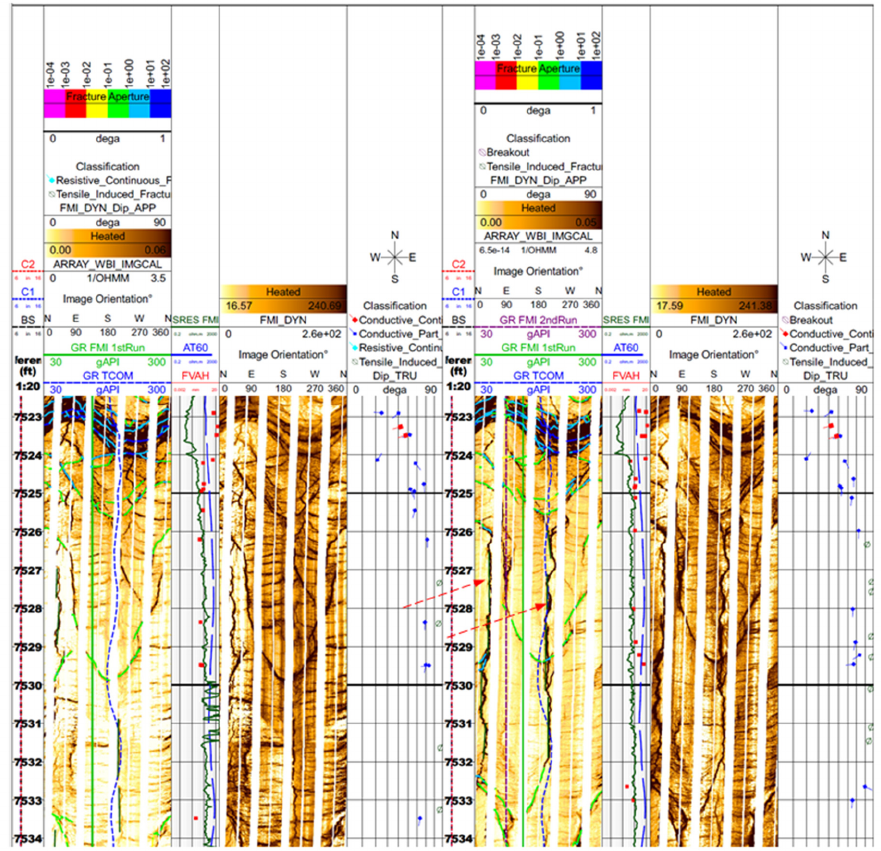
Figure 3. Comparison of Formation MicroScanner Image (FMI) logs before (left two tracks) and after (right two tracks) injection during 2017. Induced fractures are near-vertical and are shown by circles with azimuth trends to the right of the tracks. Blue tadpole symbols show the direction and dip of natural fractures. The arrows point to induced fractures that display the significant enhancement and growth after injection. Depths are in feet (to convert to meters, multiply by 0.3048). For each pair, the lighter leftmost panel is known as a static view, and the rightmost panel is a dynamic view. In “static normalization”, the resistivity range of the entire logged interval is partitioned into 256 color levels. “Dynamic normalization” can enhance features locally by rescaling the color intensity over a smaller interval, enabling the contrast between adjacent resistivity levels to be enhanced. The dashed lines that run the length of the images is the gamma ray from the triple combo logging run (GR_TCOM). The logging abbreviations: SRES FMI = synthetic resistivity, AT60 = array induction two-foot resistivity A60, and FVAH = hydraulic electrical fracture aperture, cube root of the cube of the fracture trace aperture summed over a given window height. 3. Injection Activities Well 58-32 is a pilot well for testing and monitoring at the FORGE site. This well was drilled to a total depth of 2297 m RKB and penetrated more than 1300 m of granitoid. After completion, 46 m of openhole was left below the production casing shoe. The well encountered low-permeability crystalline rocks at 968 m RKB. A static bottomhole temperature of 199 °C was measured at total depth. In September 2017, an initial injection program was carried out in the openhole section at the